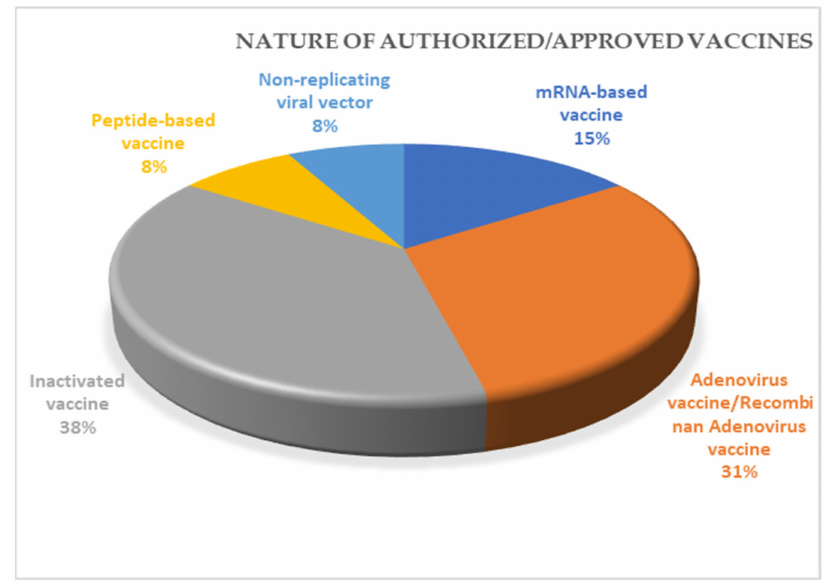
Figure 3. Nature of various types of authorized vaccines